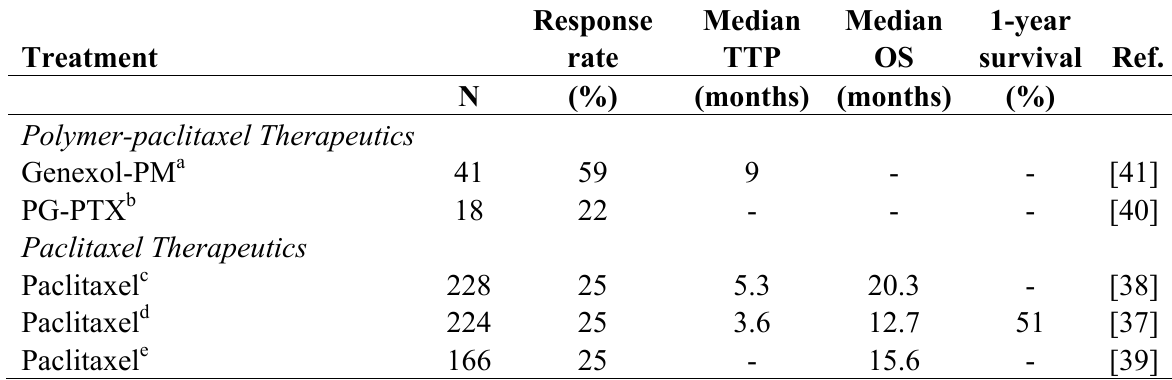
Table 11. Clinical outcomes of polymer paclitaxel and paclitaxel therapy in patients with metastatic breast